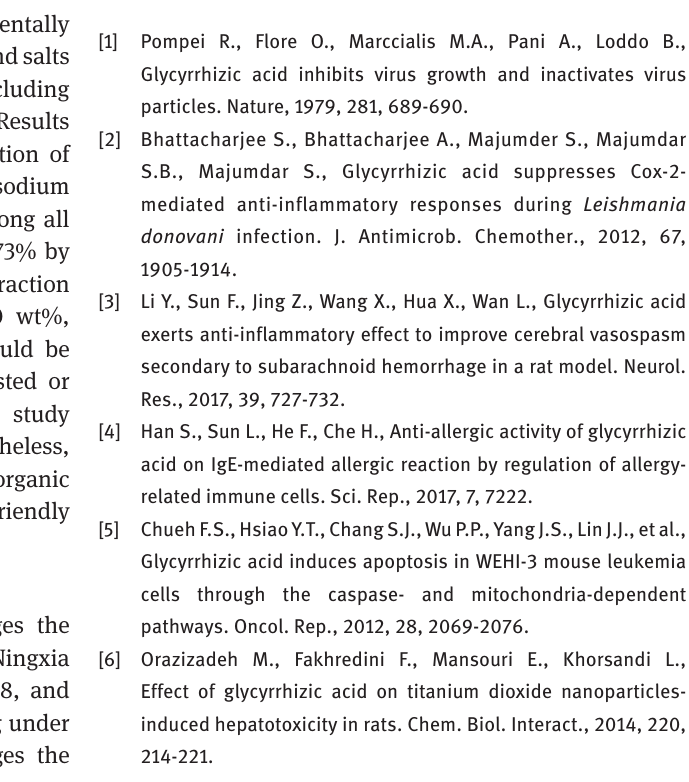
O. The mass fraction of PEG is 20% for the both 2